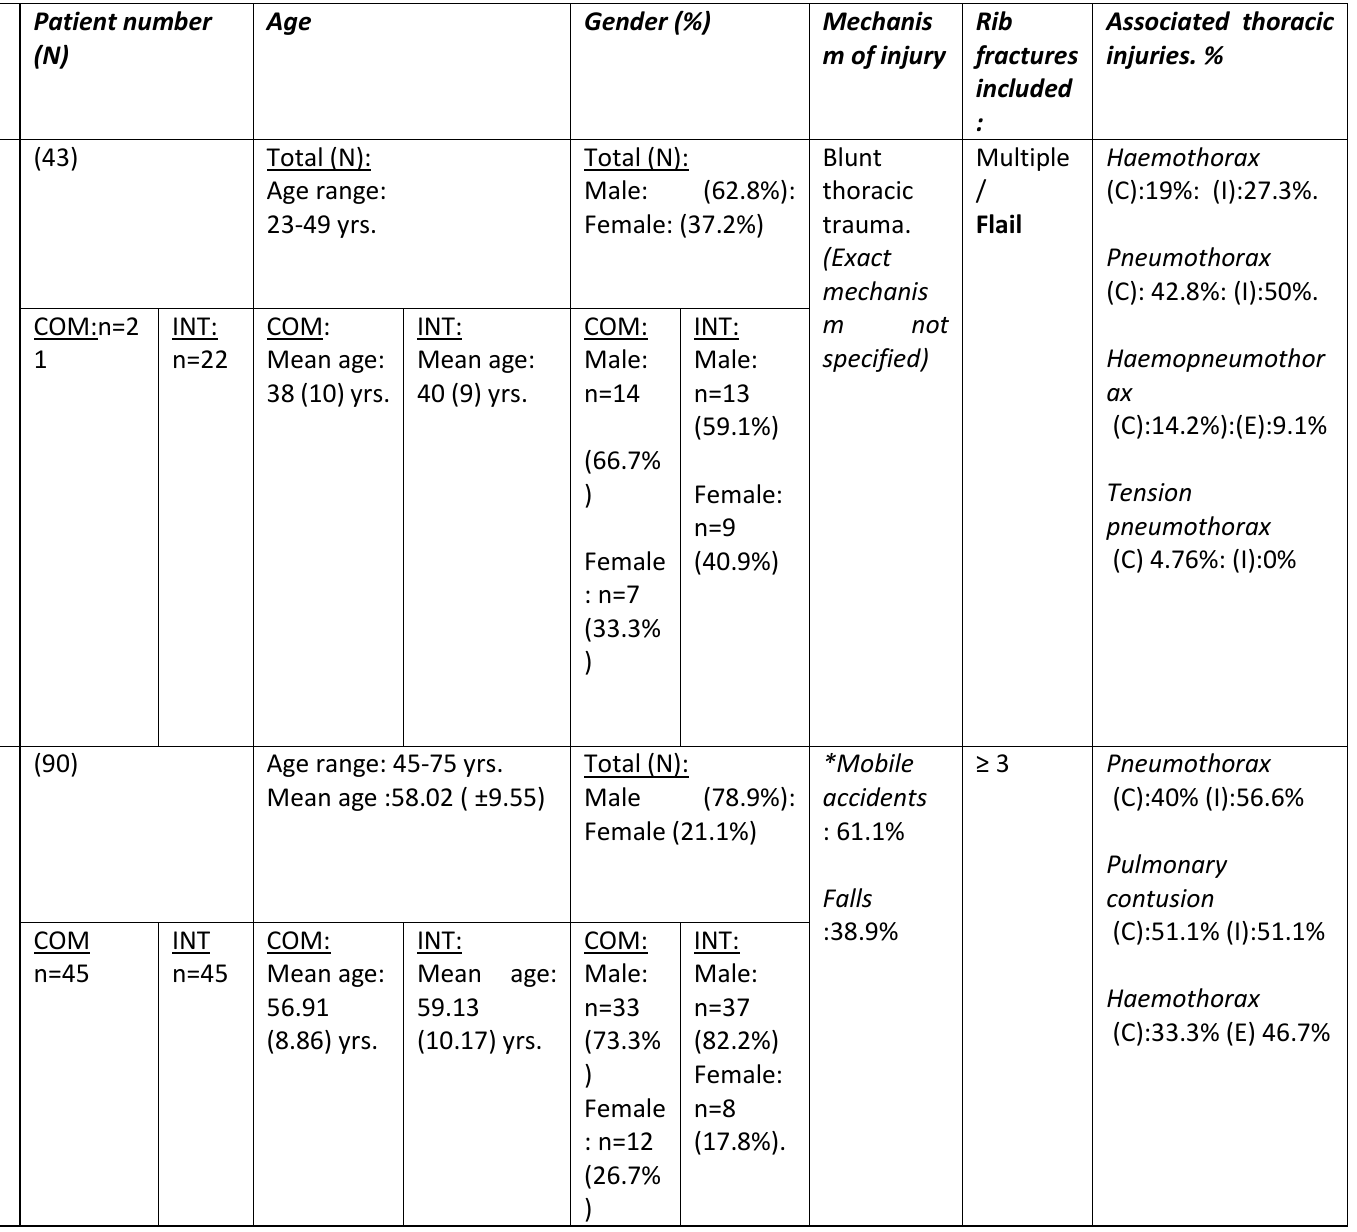
TABLE 10-A1 : Baseline characteristics and clinical profile of included studies. Authors